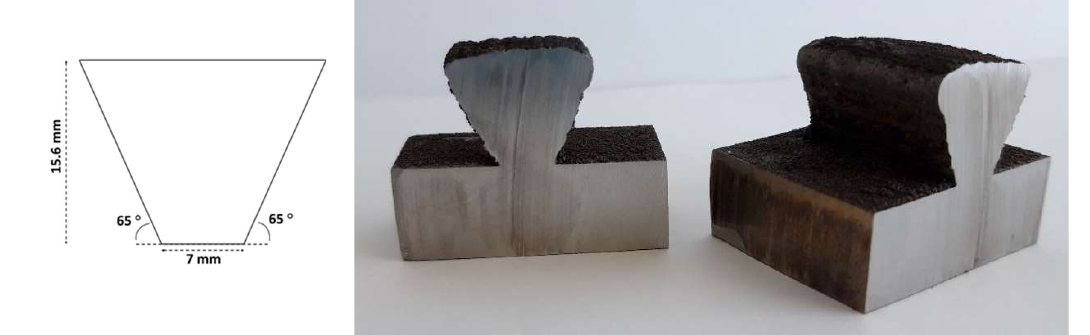
Figure 2. Dove tail structure, cross section.